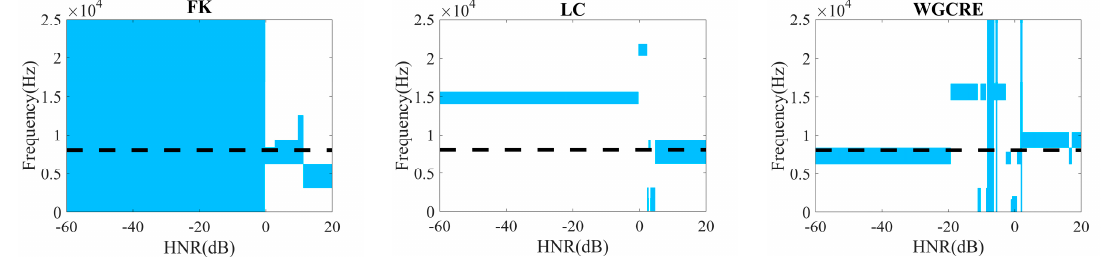
Figure 7. Selected optimal demodulation bands under single-sample dropout for different HNR.